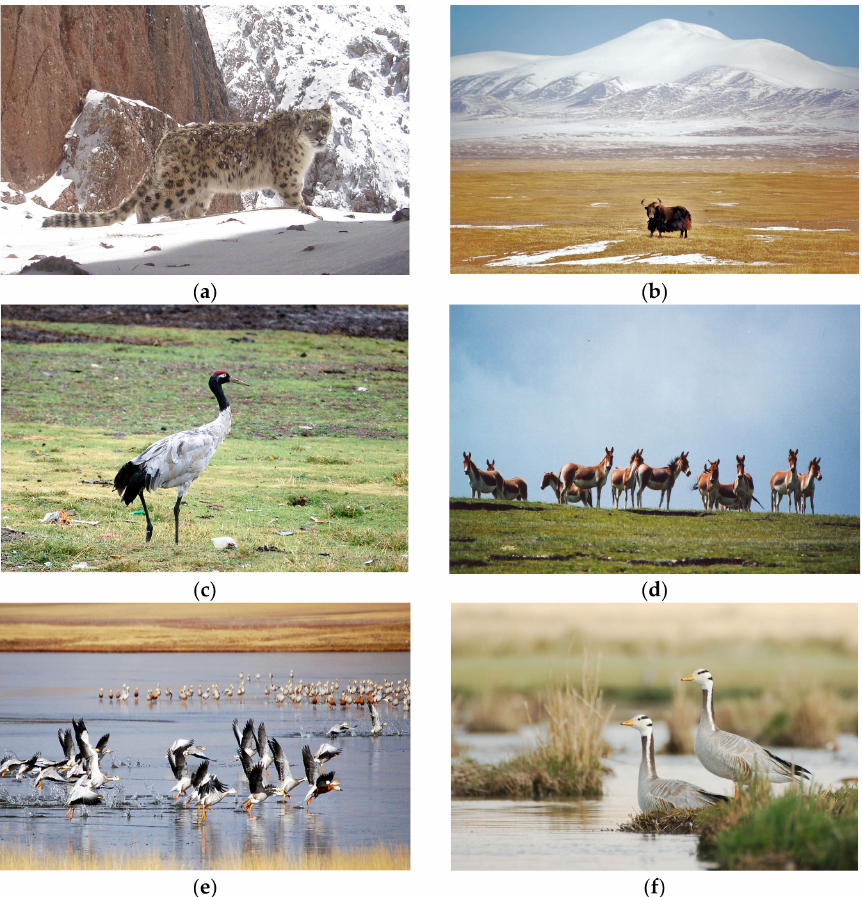
Figure 6. Endangered wildlife protected by local herding communities includes ( a ) snow leopard, ( b ) wild yak, ( c ) black-necked crane, ( d ) wild ass, and ( e ) wetland birds, including ( f ) bar-headed geese.